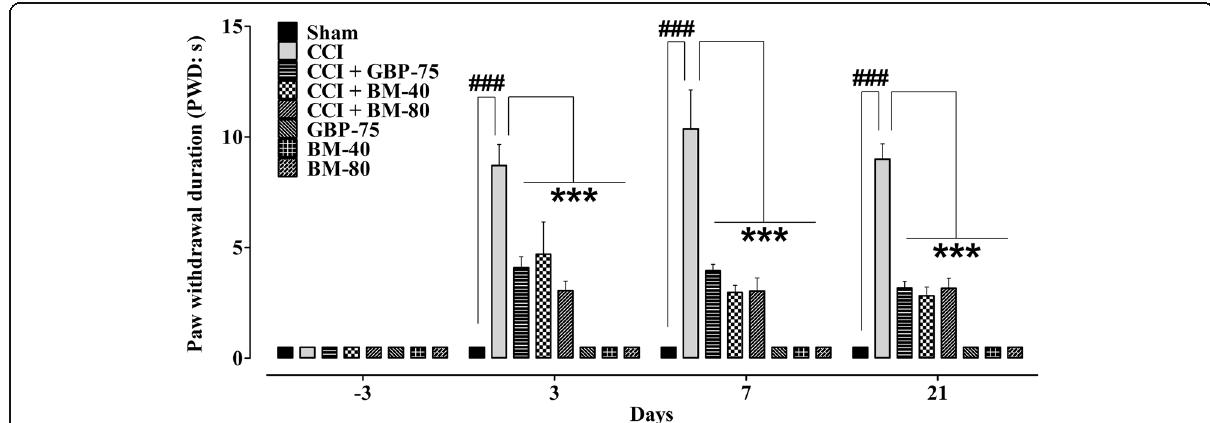
Fig. 5 Effect of Bacopa monnieri methanolic extract (BM-40 and BM-80) and gabapentin (GBP-75) on the maintenance of chronic constriction injury (CCI) induced punctate hyperalgesia (increased paw withdrawal duration to pin prick; PWD in s). Values expressed as mean ± S.E.M. ### P < 0.001 compared to sham-operated animals, *** P < 0.001 compared to CCI-operated untreated animals, two-way repeated